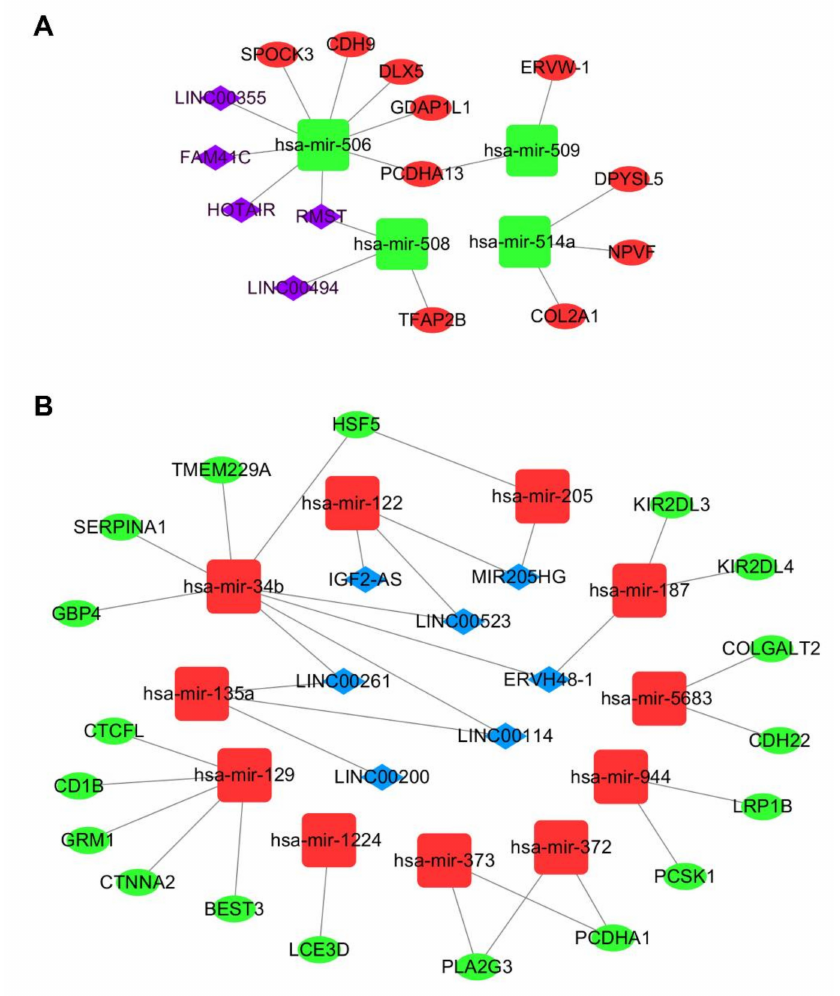
Figure 3. Metastasis-associated ceRNA network for colorectal cancer (CRC). ( A ) Green squares represent downregulated miRNAs, red ellipses represent upregulated mRNAs, and purple diamonds represent upregulated lncRNAs. ( B ) Red squares represent upregulated miRNAs, green ellipses represent downregulated mRNAs, and blue diamonds represent downregulated